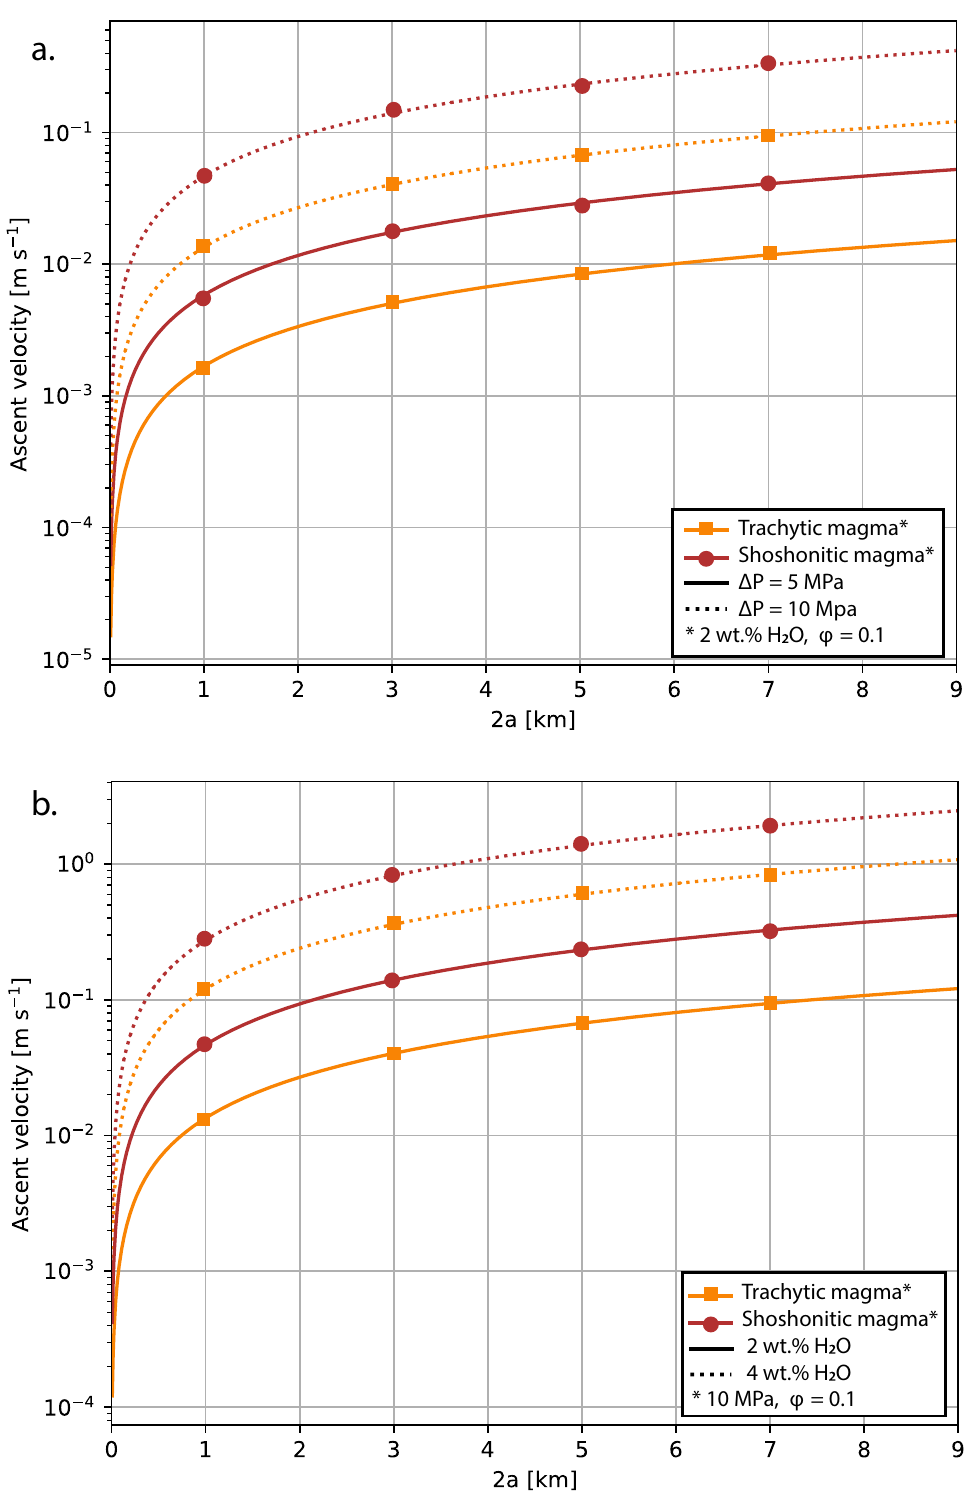
Fig. 4 Modeled ascent velocities of magmas from a 9 km reservoir, calculated after Rubin 1993 for different magmatic compositions and different values of overpressure at the